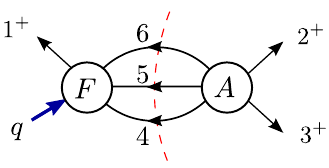
Figure 7 . Triple cut of the two-loop form factor in the s 23 -channel.